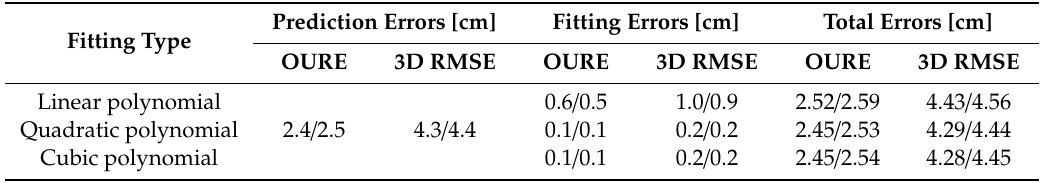
Table 8. Total error budget of the Level B orbital products. The results at the prediction time of 1 and 60 s are separated by “ /